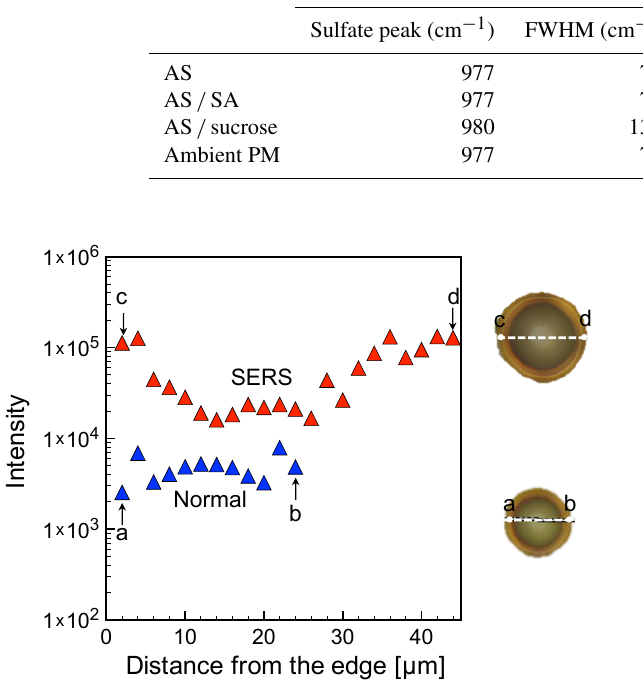
Figure 6. Raman intensity as a function of distance from edge to edge of the AS / sucrose particles: points a to b for normal Raman (blue) and points c to d for SERS (red) measurements. Optical im- ages of corresponding particles were also shown.